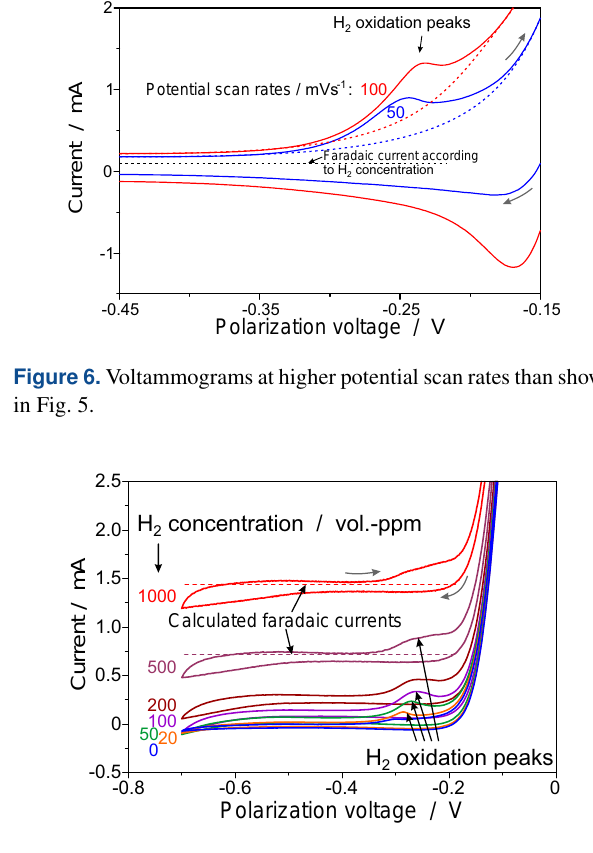
Figure 7. Voltammograms for measuring gases at different H 2 con- centrations; cell temperature: 750 ◦ C; gas flow rate: 10sccm; elec- trode size: 7.5cm 2 ; potential scan rate: 10mVs − 1 ; the second cycle is shown.